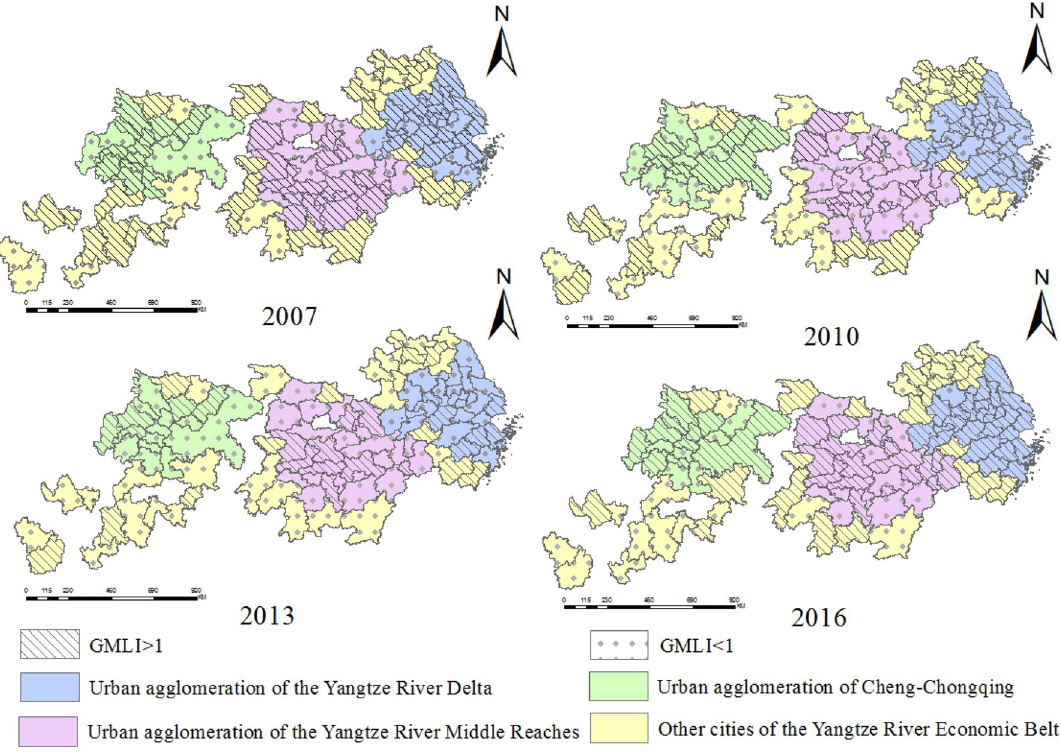
Figure 4. Spatial distribution map of GMLI in 2007, 2010, 2013 and